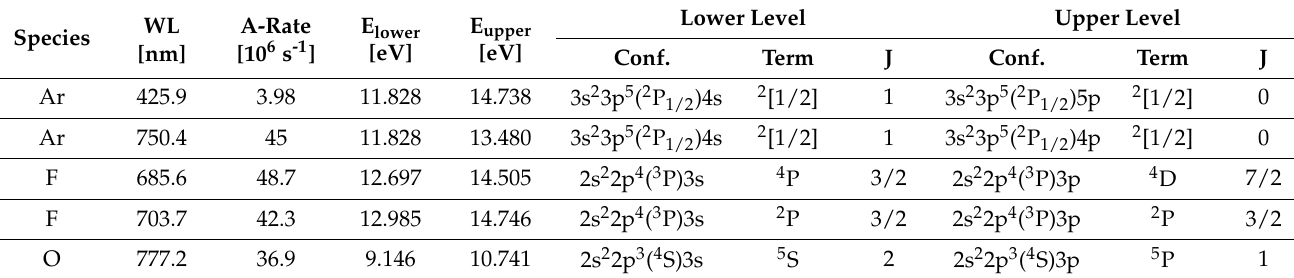
Table A1. Optical emission spectrum information of argon, fluorine, and oxygen atom [25]. Species